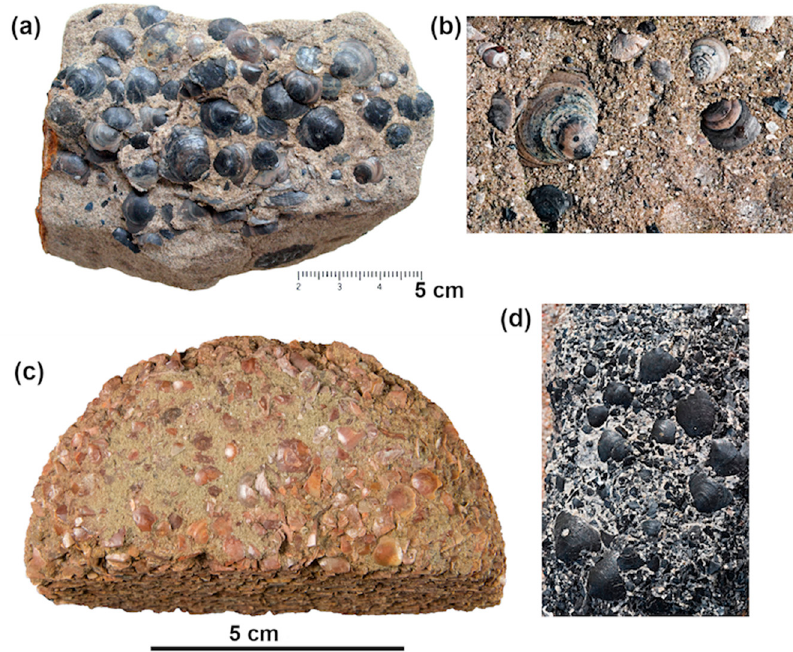
Figure 5. Varieties of Estonian sandstone-hosted shelly phosphorite. Photos: T. Saadre ( a , c ) H. Bauert ( b , d ), University of Tartu and Geological Survey of Estonia.